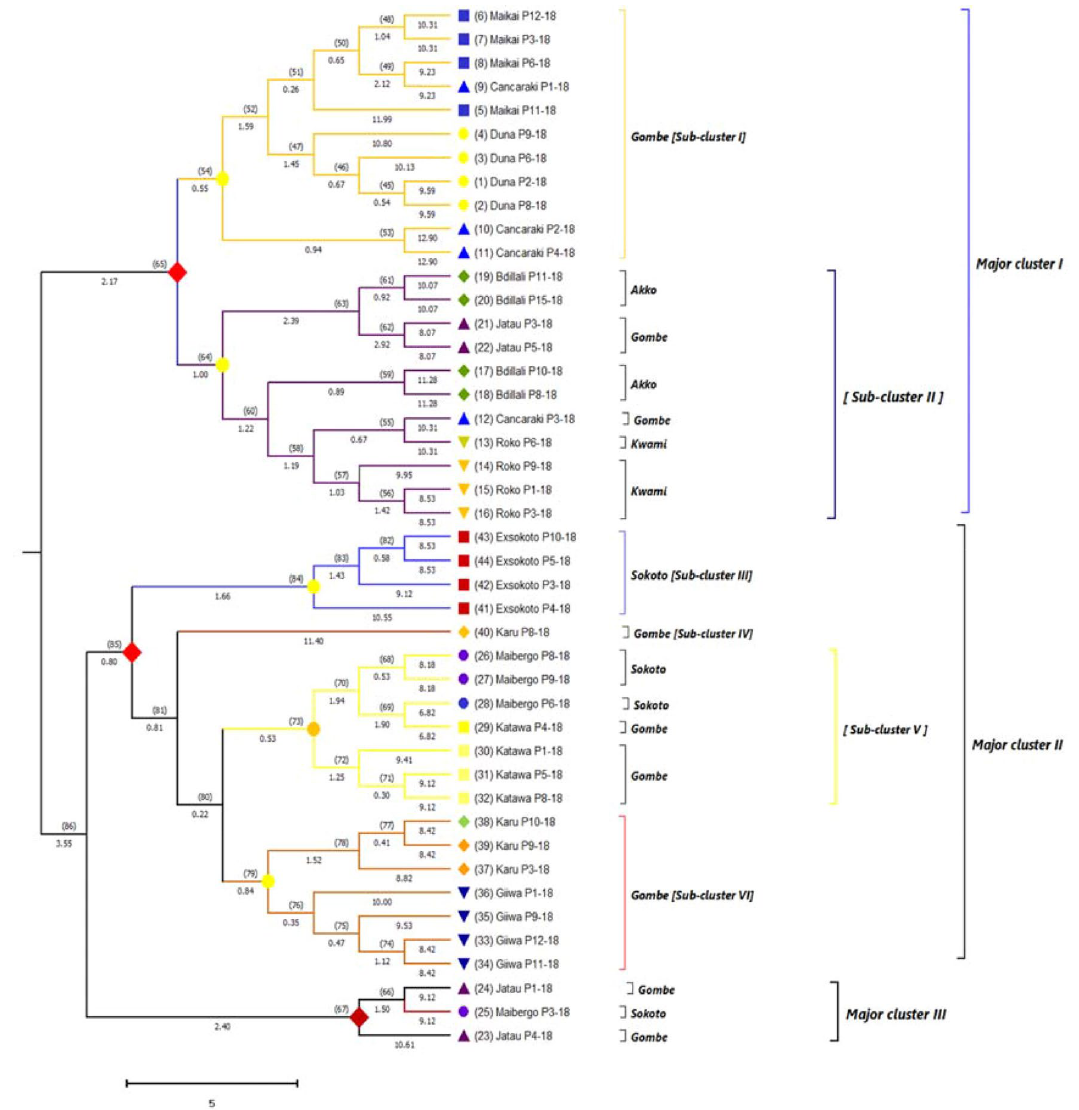
Figure 4. The UPMGA phylogenetic tree illustrating the genetic inconsistency and visual relationship among V. suberranea genotypes based on Nei’s genetic distance. In the phylogenetic tree, individual accessions under the same population were marked with similar symbols (circular, square, upward tringle, downward tringle, and diamond shape, etc.) with identical colors. The numeric value beneath branches displayed the edge length (EL) and in the parenthesis upper the branch was node number (NN) while the numeric value in parenthesis behind the accessions name indicates genotype number (Table